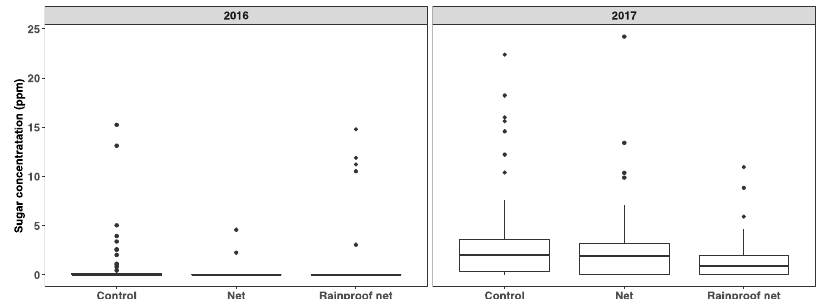
Figure 3. Sugar concentration at harvest on the surface of fruits from row units covered. With nets or rainproof nets compared to unnetted row units. The mid horizontal bar of the box represents the median, the two hinges correspond to the 25th and 75th percentiles. Whiskers extend 1.5 × above and below the interquartile range. Data beyond the end of the whiskers were plotted individually.